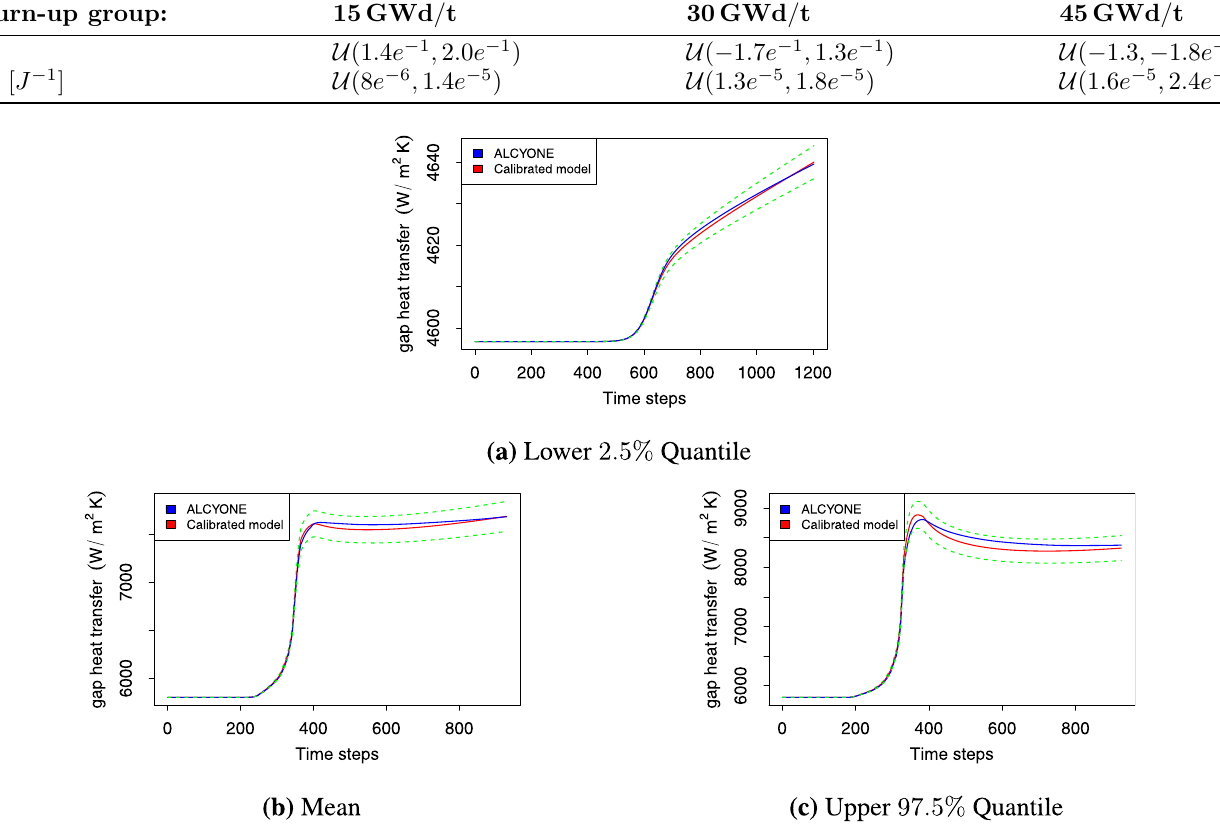
Fig. 10. 15 GWd / t H gap model prediction with its uncertainty bounds in green.